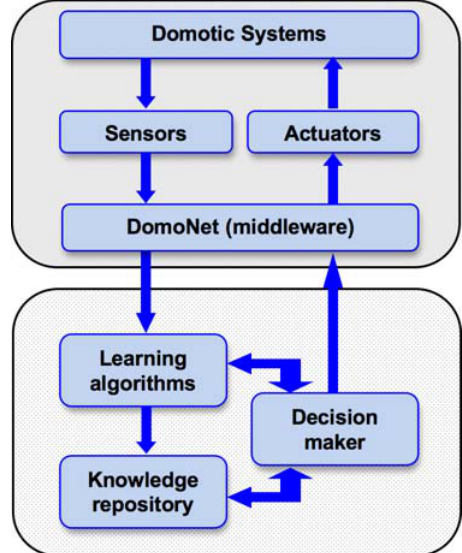
Figure 6. The DomoPredict